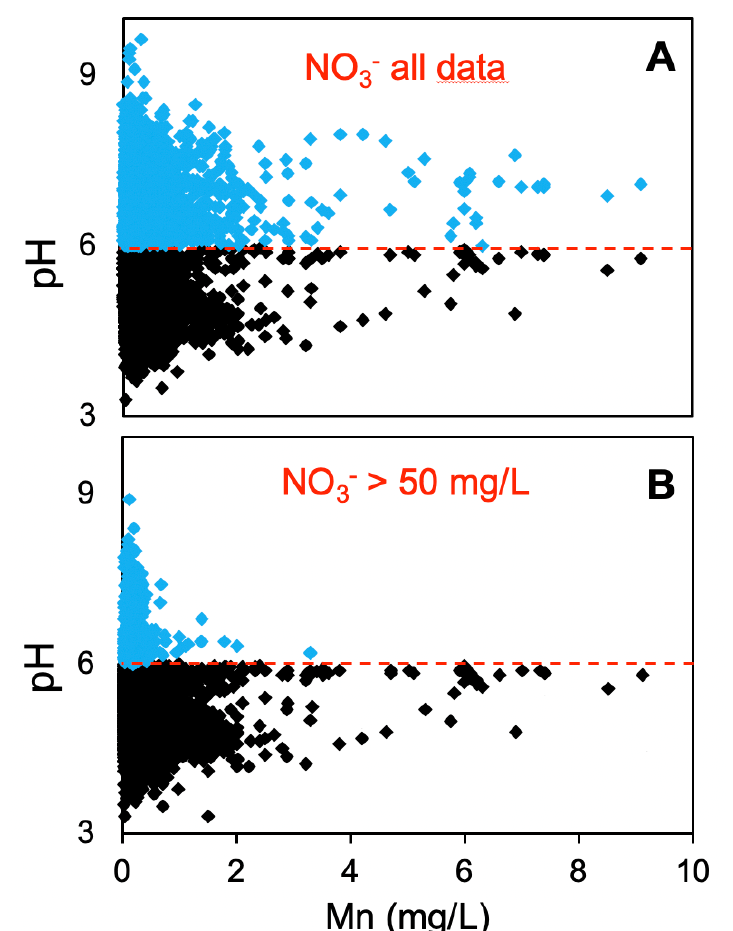
Figure 9. Mn—pH relationship at varying nitrate (NO 3 − ) concentrations, i.e., ( A ) all concentrations and ( B ) concentrations above the drinking water threshold of 50 mg / L. The horizontal dashed red line marks pH 6 and the vertical dashed red line indicates the 0.3 mg / L “non-enforced” U.S. Health Reference Level for Mn.